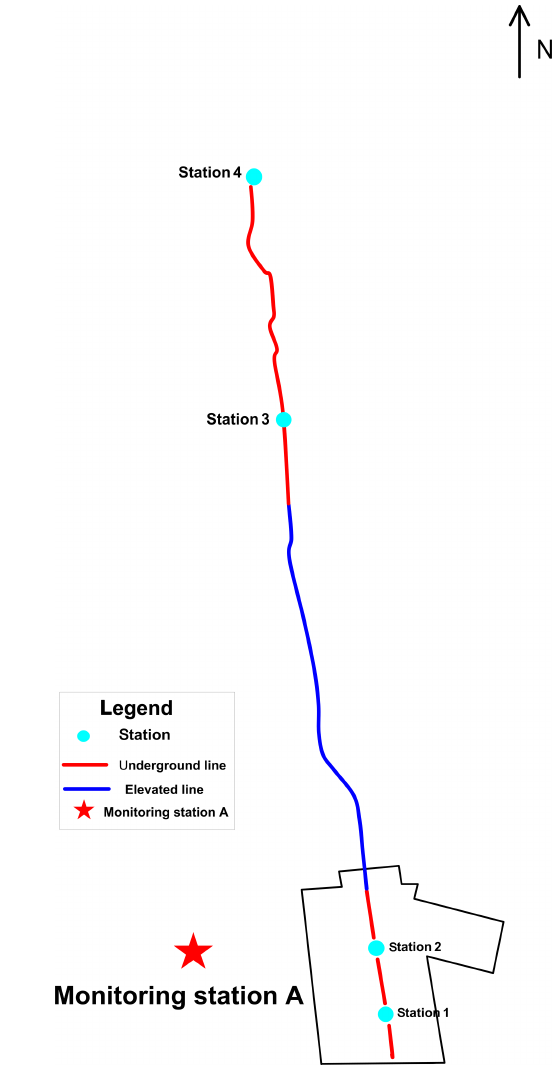
Figure 1. Schematic diagram of the fast railway line B.